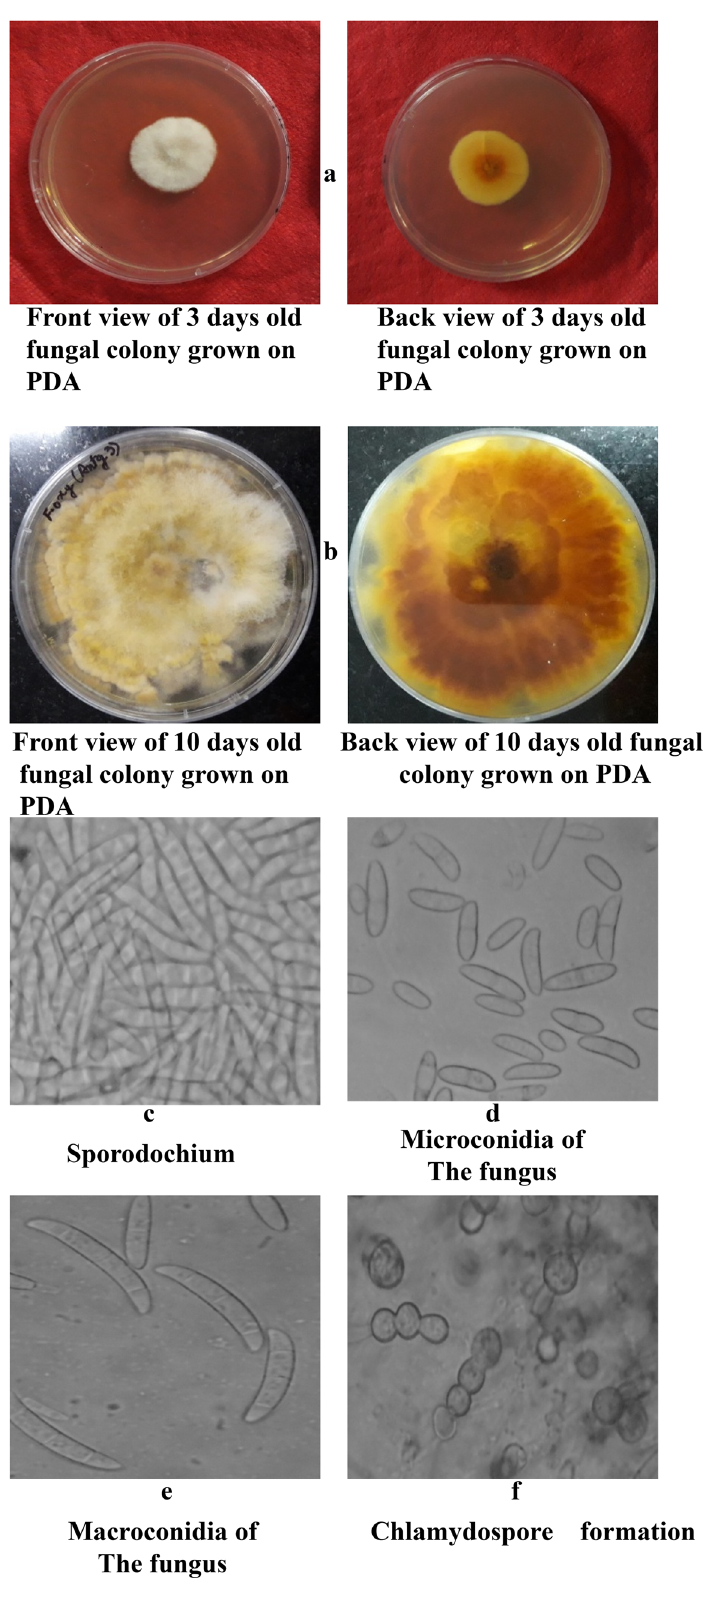
Figure 3. Morpho—cultural characteristics of Fusarium oxysporum Schlecht. Causing chilli